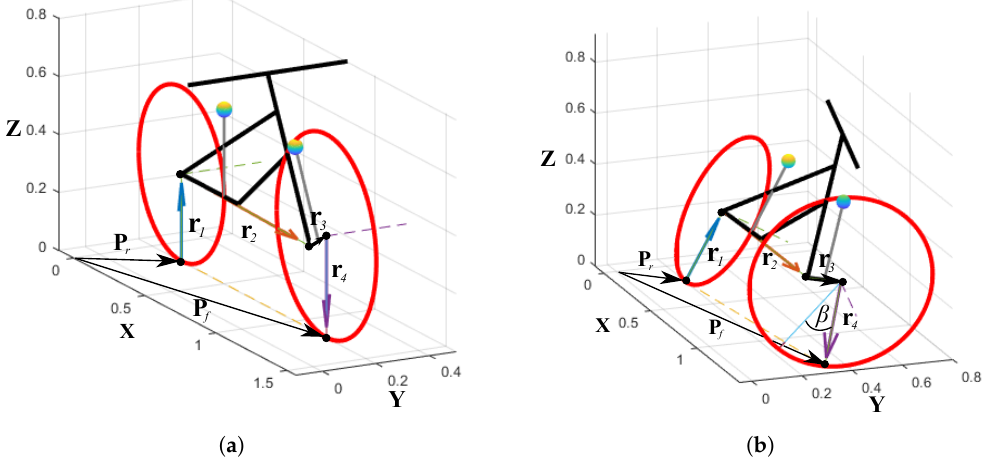
Figure 6. The angular migration of the contact point between the front wheel and the road. ( a ) Upright initial position. ( b ) Arbitrary